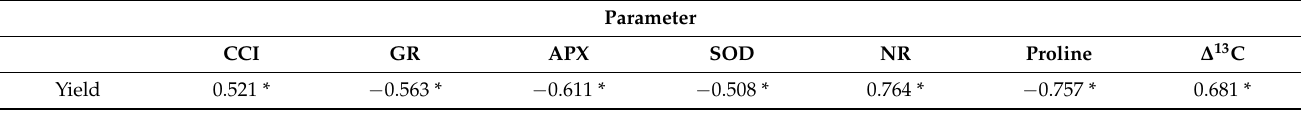
Table 6. Pearson correlation coefficients of yield versus leaf chlorophyll content index (CCI), glu- tathione reductase (GR), ascorbate peroxidase (APX), superoxide dismutase (SOD), nitrate reductase (NR), proline content, and 13 C discrimination ( ∆ 13